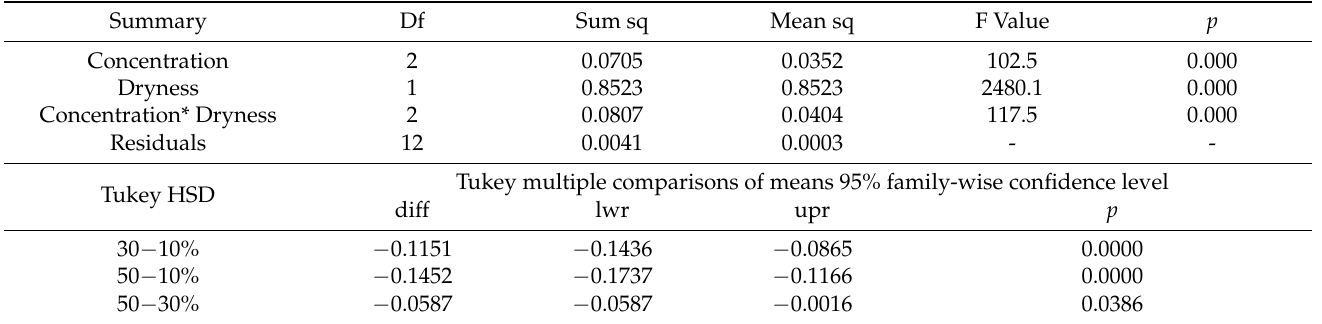
Table 15. Summary of factor importance and Tukey HSD results